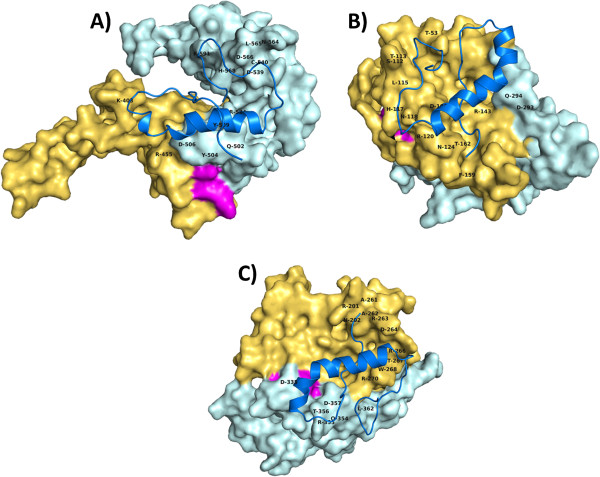
Prt/ZP domain, predicted binding. (A) Prt/ZP2 (ZP domain) model; (B) Prt/ZP3(ZP domain) model; (C) Prt/ZP4(ZP domain) model. ZP domains and Prt are shown respectively in surface and cartoon representations. N-terminal region of ZP domain is coloured in yellow-orange. C-terminal region of ZP domain is coloured in pale cyan. Expected Internal Hydrophobic Patch (IHP) interdomain linker (using the mouse and human IHP linkers as templates; as described in Jovine et al. [67]), are coloured in magenta. Polar contacts with corresponding ZP amino acids are indicated with one-letter code. Based on UniProtKB/Swiss-Prot sequences [Prt (A4ULE2); ZP2 (Q9BH10; a.a. 366–632); ZP3(P48830; a.a. 44–306); ZP4(Q9BH11; a.a. 188–465)].